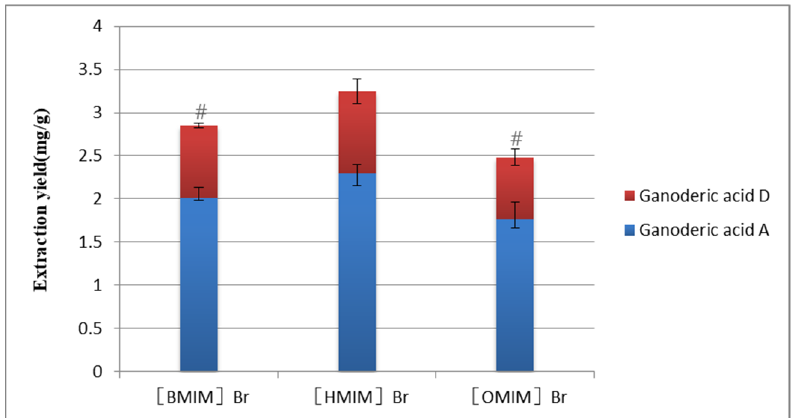
Figure 3. Influence of different types of cations on the extraction yield. Compared with [HMIM] Br/methanol group: # p < 0.05.